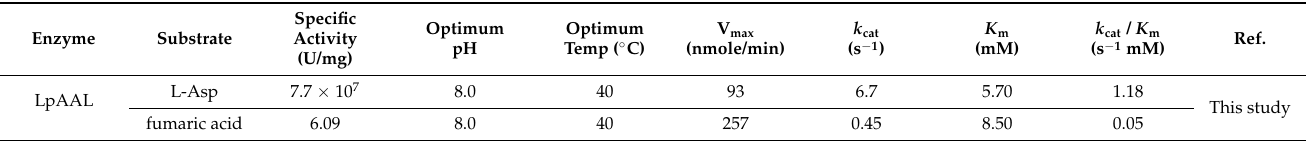
Table 2. Comparison of biochemical properties and kinetic parameters of AAL activities in various AAL